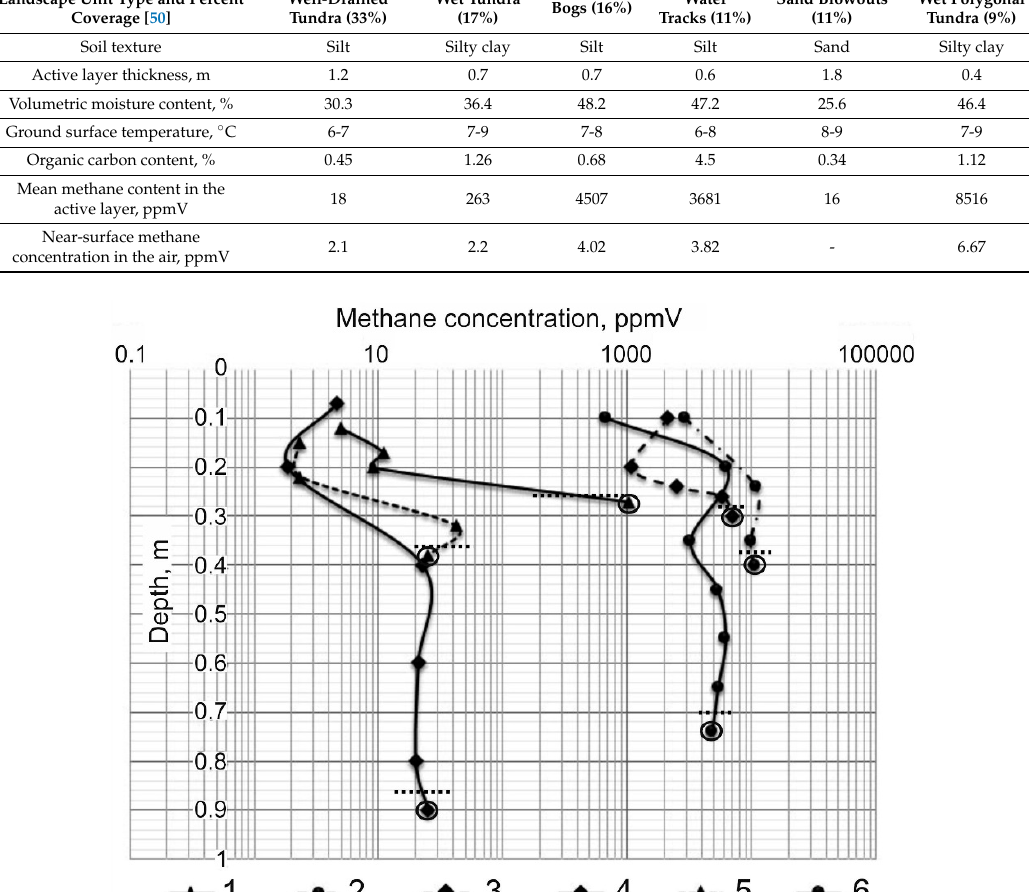
Table 3. Spatial variability of the methane in the active layer of various types of landscape units characteristic of typical tundra of the Marre-Sale site.